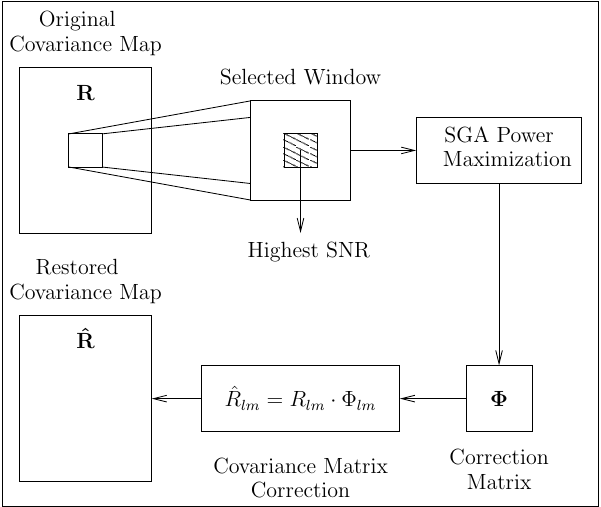
Fig. 4. Proposed phase calibration